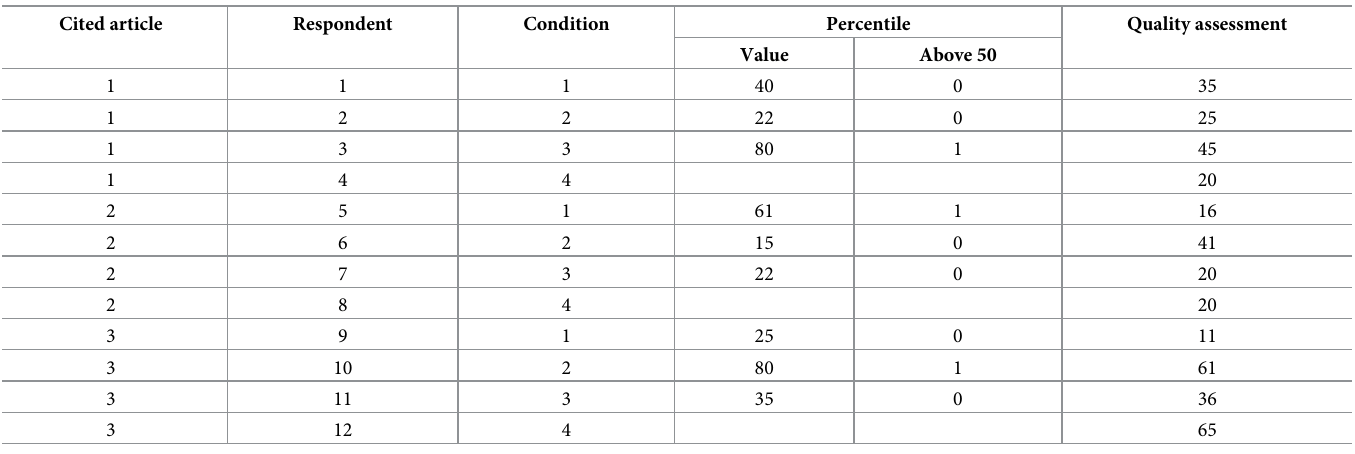
Table 2. Fictitious data in the long format for one quality